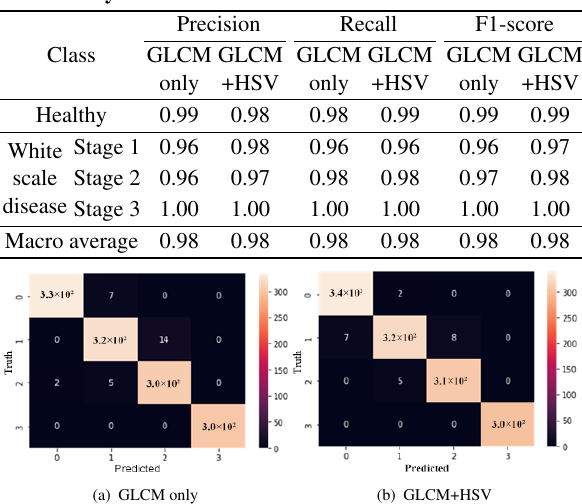
Fig. 6 Confusion matrices of SVM classifier. 0–3 indicate healthy, low infestation degree, medium infestation degree, and high infestation degree, respectively. The color metric scale represents the number of prediction in the confusion matrices.